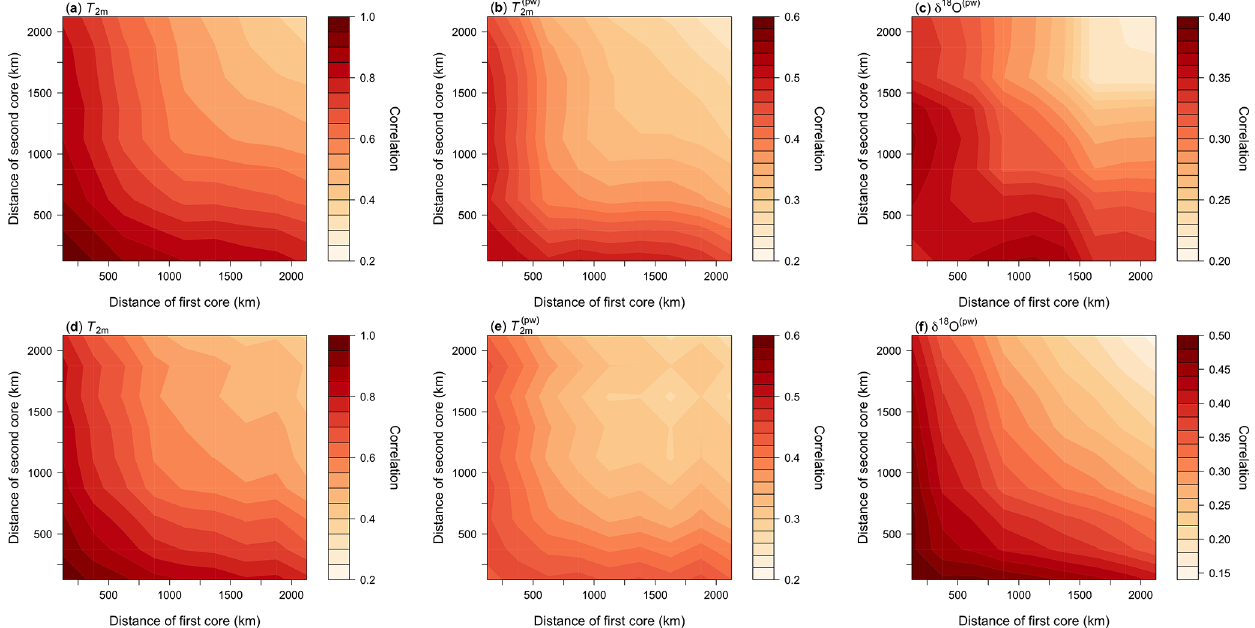
Figure 6. Average sampling correlation structure with temperature for the DML and Vostok regions in the two-dimensional case of sampling two locations. Shown is the mean correlation of all possible single correlations between the target site temperature and the average of two grid cells of ( a , d ) T 2m , ( b , e ) T (pw) , and ( c , f ) δ 18 O (pw) time series sampled from the same ring or from two different rings. This analysis 2m was conducted for every target site in the DML region ( a – c ) and in the Vostok region ( d – f ), and the results were then averaged across the respective region. For each plot, the axes display the distance from the target site; the x ( y ) axis represents the first (second) sampled ring, with the results being mirrored along the diagonal for aesthetic reasons. The tick marks indicate the border distances of the rings. Note the marked difference in the locations of the correlation maxima between T 2m and δ 18 O (pw) for the DML region, and also for the Vostok region the – albeit marginal – correlation maximum for δ 18 O (pw) is achieved by combining the innermost ring with the ring between 500 and 750km.